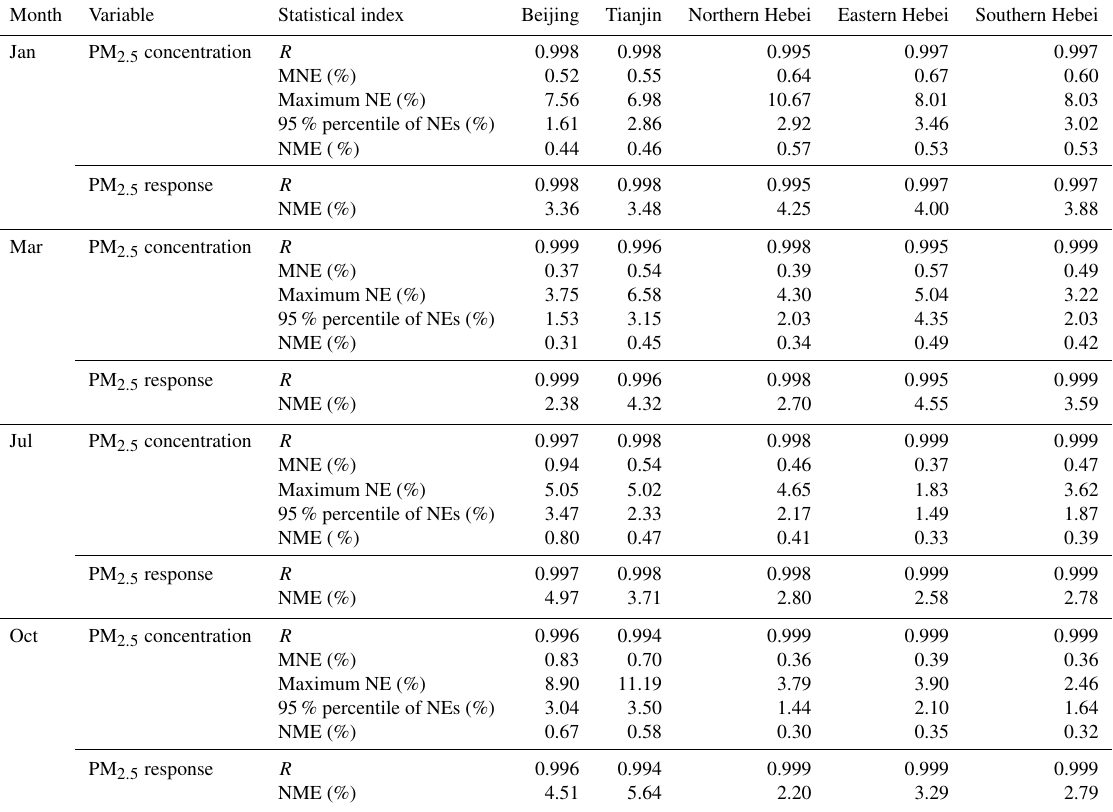
Table 2. Comparison between ERSM-predicted and CMAQ/2D-VBS-simulated PM 2 . 5 concentrations for 54 out-of-sample